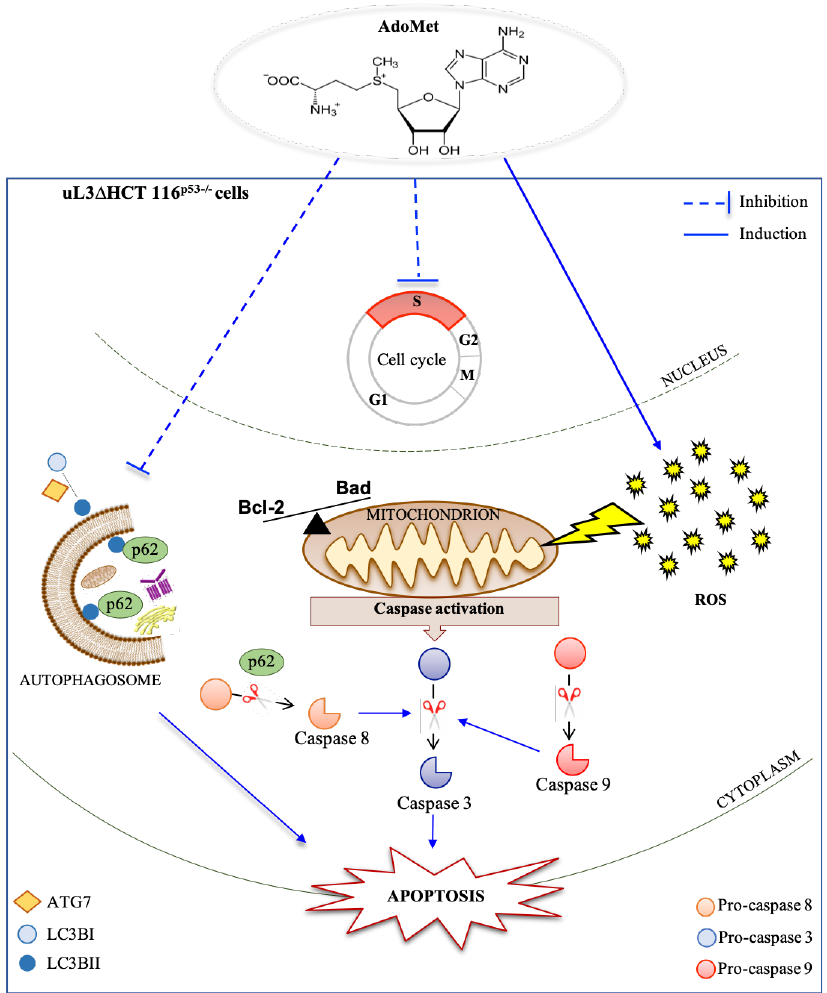
Figure 7. Schematic representation of the proposed model of AdoMet effects in uL3∆HCT 116 p53 −/− colon cancer cells. AdoMet treatment affected cell proliferation causing cell cycle arrest in the S phase. The inhibition of the autophagic process and induction of ROS upon exposure to AdoMet led to activation of the caspase cascade, triggering the apoptotic pathway.